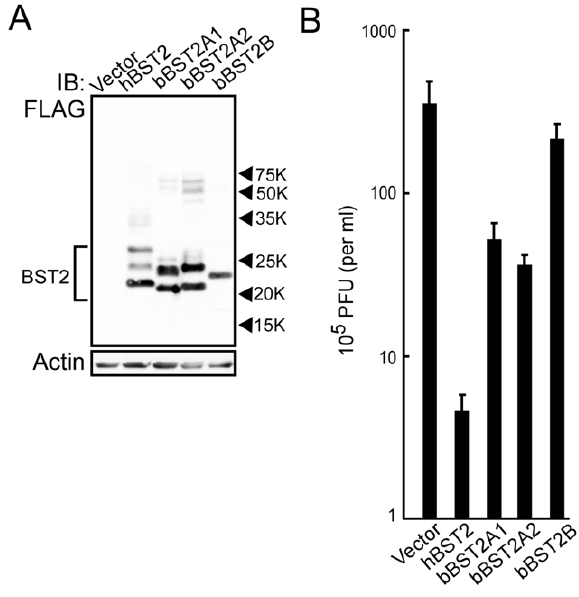
Figure 7. Antiviral activity of bovine BST-2s against VSV. Expression plasmid for bBST-2A1, bBST-2A2, bBST-2B or hBST-2 was transfected into MDCK cells by electroporation. (A) Cells were dissolved at 16 h after transfection and then subjected to 12.5% SDS-PAGE. Intracellular expression of BST-2s was confirmed by Western blotting using anti-FLAG antibody. (B) At 24 h after transfection, cells were infected with VSV at MOI of 0.001. At 12 h after infection, culture supernatants were collected and virus production was determined by plaque assay. The experiments were conducted in triplicate, and the data are shown as the means 6 standard deviation.